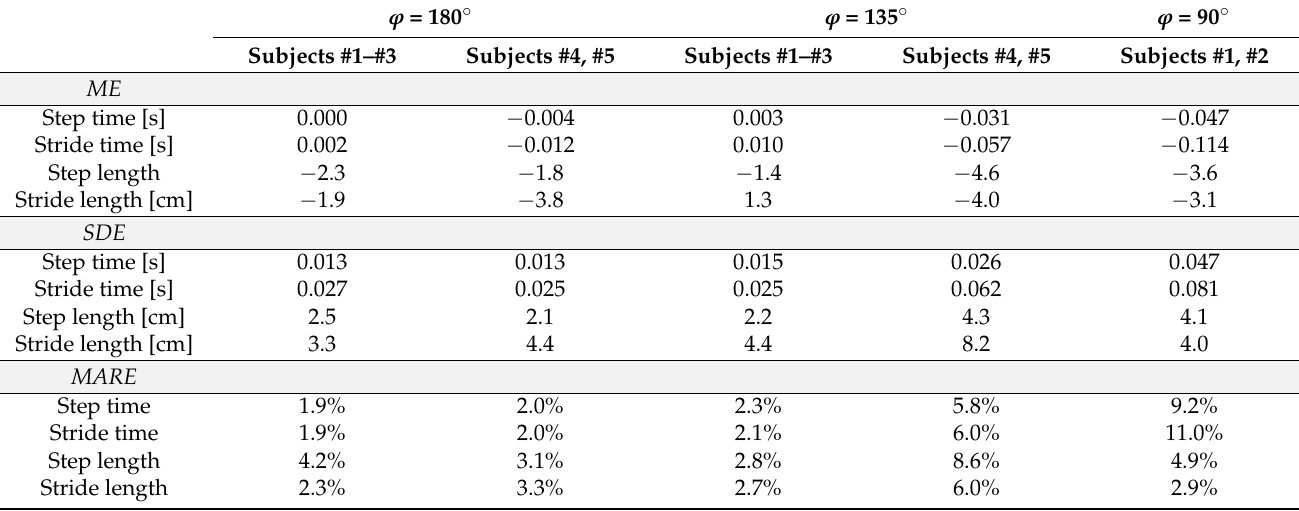
Table A3. The indicators of accuracy of the estimates of spatiotemporal gait parameters, obtained using the CH